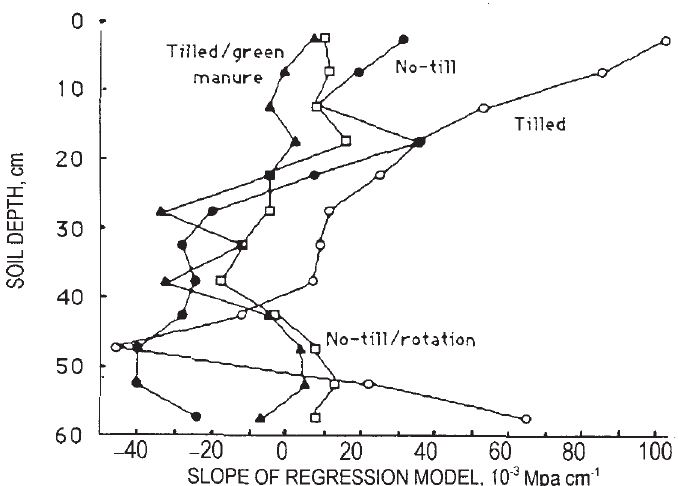
measurementsFigure 5. Slope of models for dynamic resistance in the trafficked interrow regressed on distance from the corn